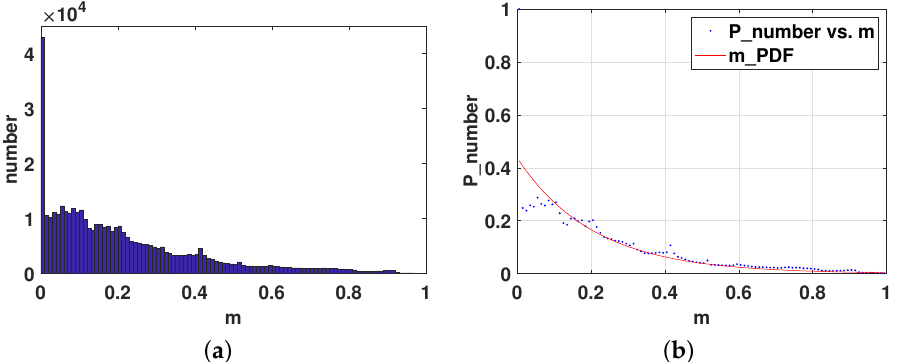
Figure 3. ( a ) A semantic sensitivity histogram; ( b ) A semantic sensitivity PDF